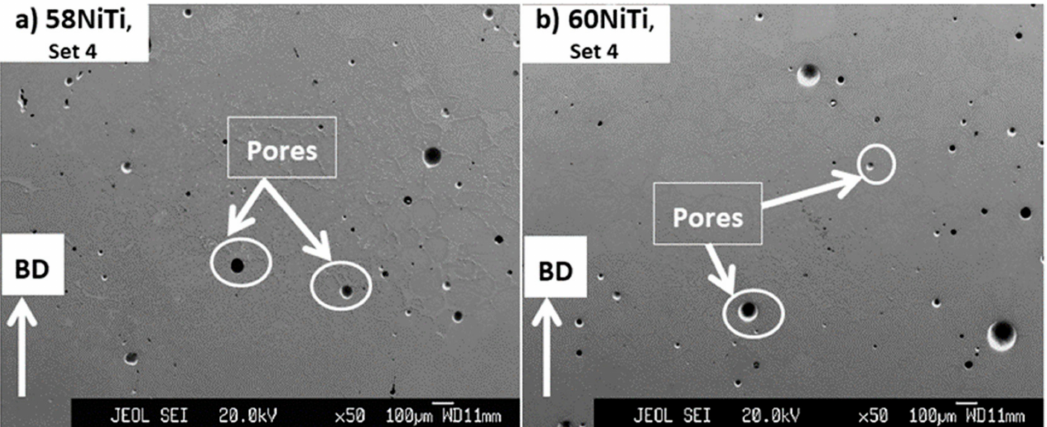
Figure 11. Images obtained from the cross-section of secondary HIP-treated ( a ) 58NiTi and ( b ) 60NiTi samples processed from parts printed by set 4 having an energy input of 39.68 J/mm 3 . The secondary HIP treatments for 60NiTi parts were conducted at 1167 ◦ C and for 58NiTi ones at 1175 ◦ C. Some of the pores seen in the microstructure of these samples are shown in the